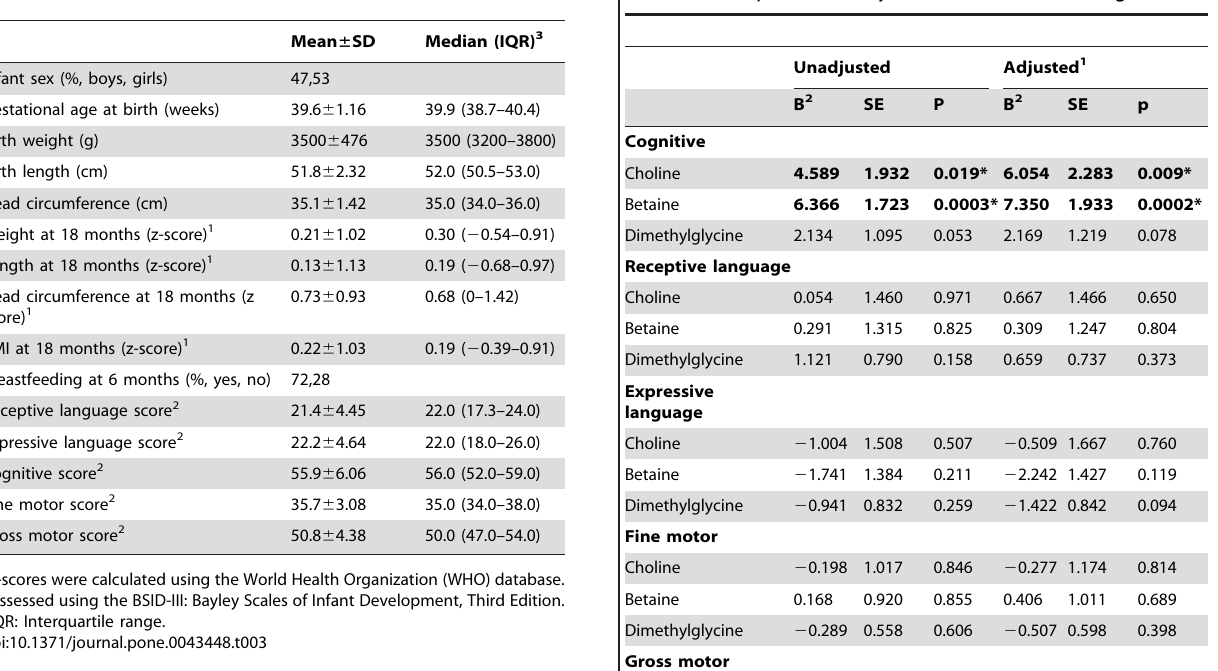
Table 4. Unadjusted and adjusted regression analyses of the association between infant neurodevelopment at 18 months and maternal plasma methyl donors at 16 weeks of